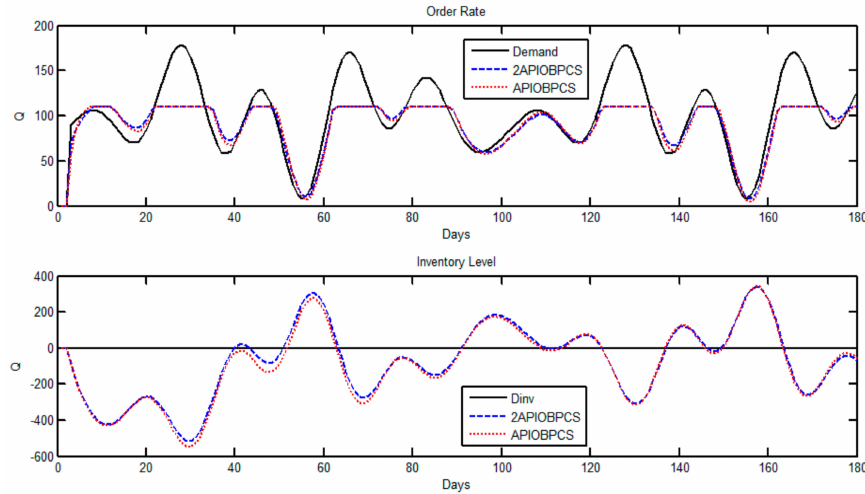
Figure 6. Simulation of Case 2 using Set 2 for the APIOBPCS and 2APIOBPCS models. Order rate ( top ) and inventory level ( bottom ).